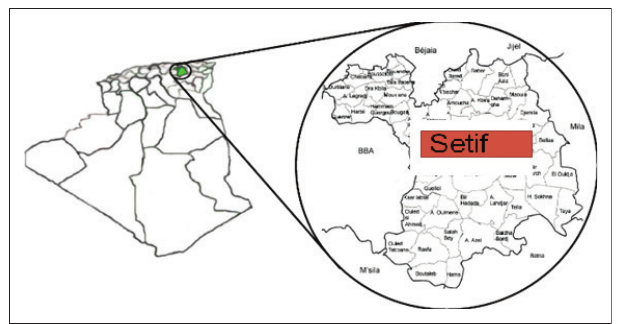
FIGURE 1: Location of Setif city.